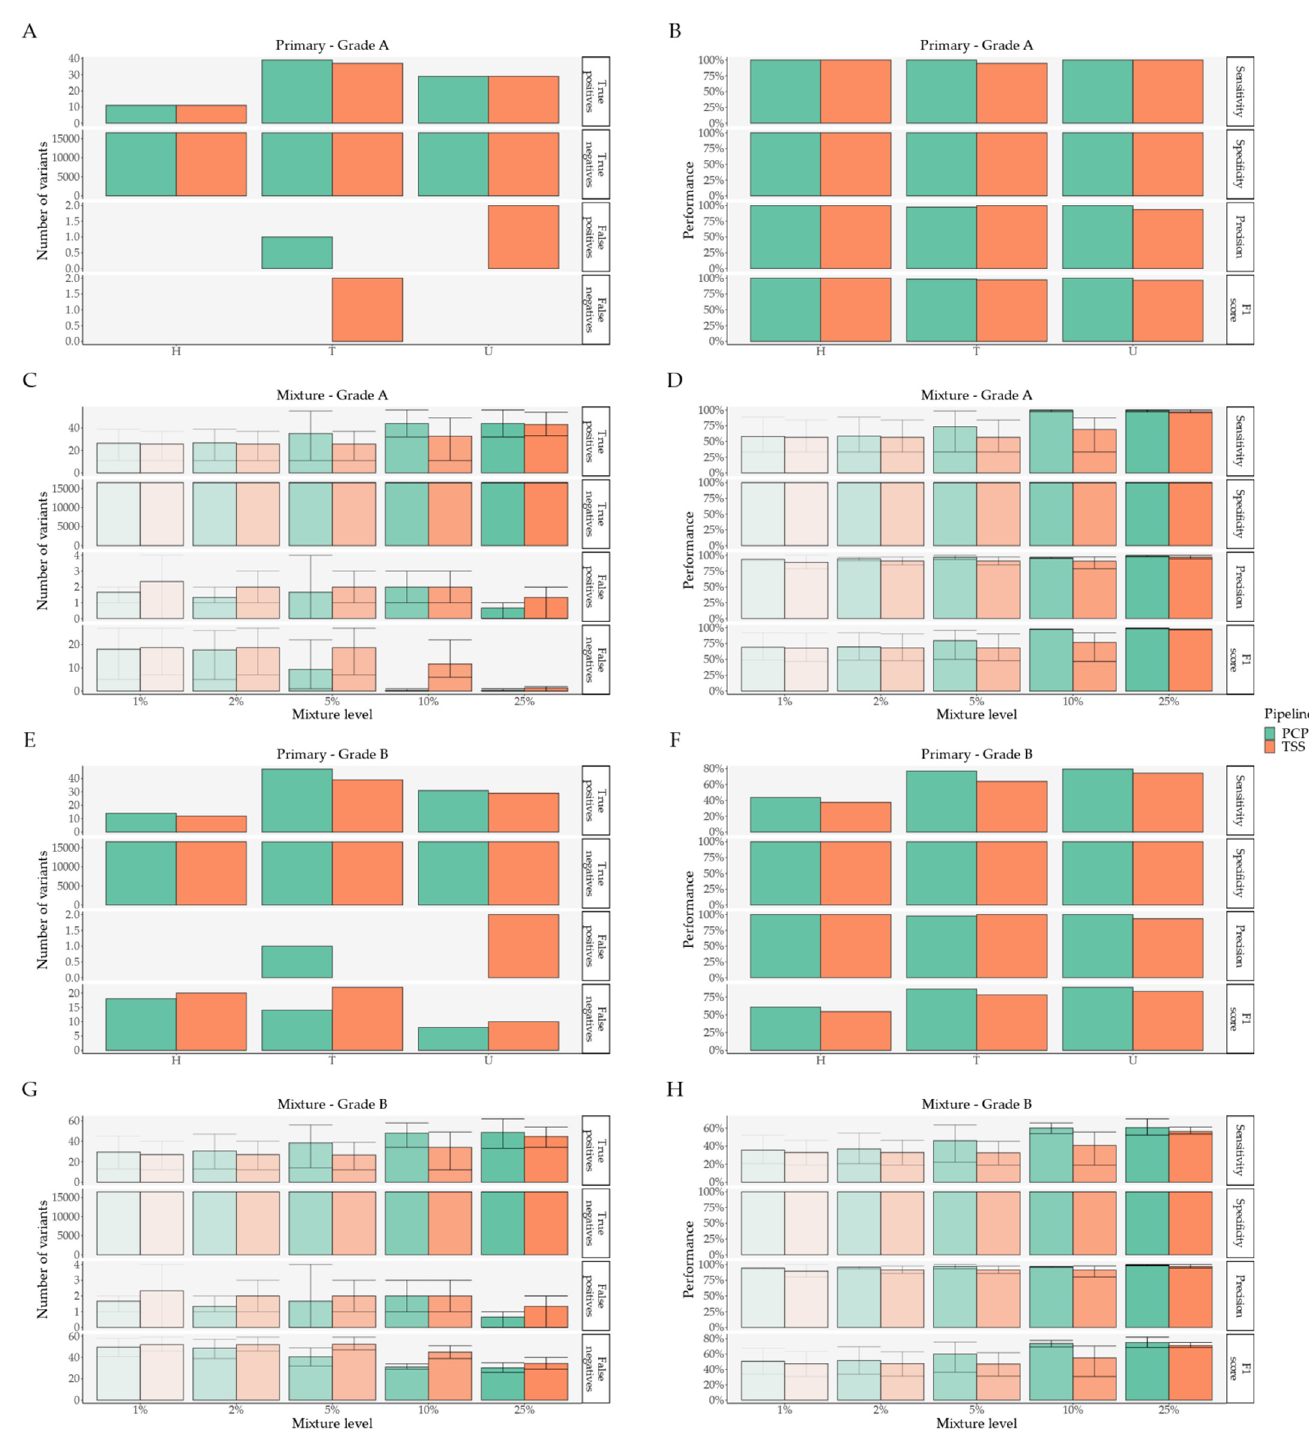
Figure A1. Performance analysis in PCP and TSS. ( A, C, E, G ) Performance metric variant classification per pipeline for Primary Grade A, Mixture Grade A, Primary Grade B, and Mixture Grade B datasets, respectively; ( B, D, F, H ) Performance metrics per pipeline for Primary Grade A, Mixture Grade A, Primary Grade B, and Mixture Grade B datasets, respectively. Error bars denote minimum and maximum values. Abbreviations: PCP—PrecisionCallerPipeline; TSS—Ion Torrent Suite™ Software.